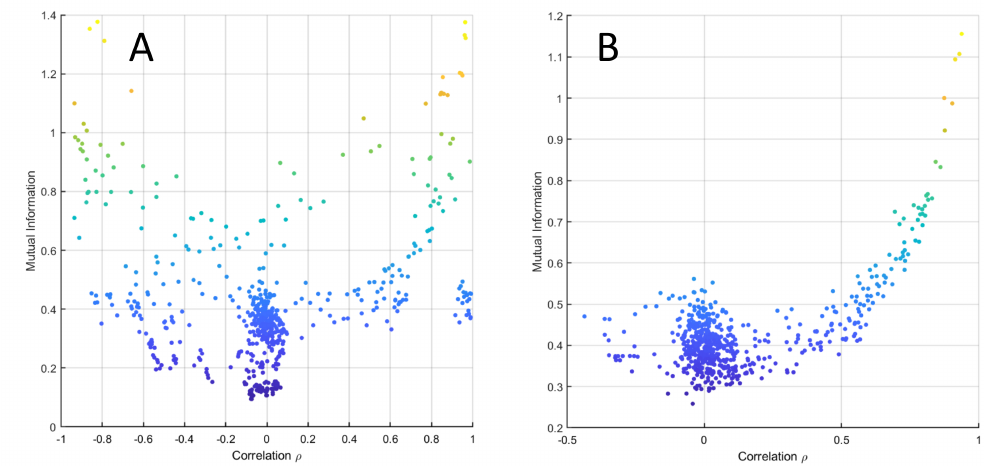
Figure 9. MI versus Pearson’s correlation from data simulated with the NK-kB dynamic model when with ( A ) (cid:101) = 0.1 and ( B ) (cid:101) =